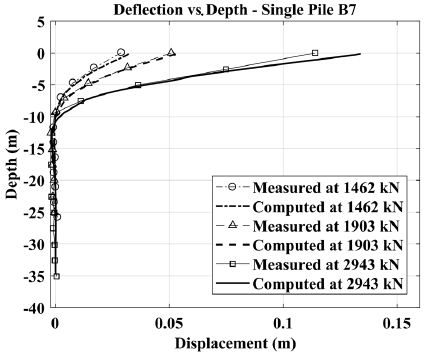
Figure 11. Pile deflections versus depth for B7 single pile under various load levels: Computed data obtained considering suction.